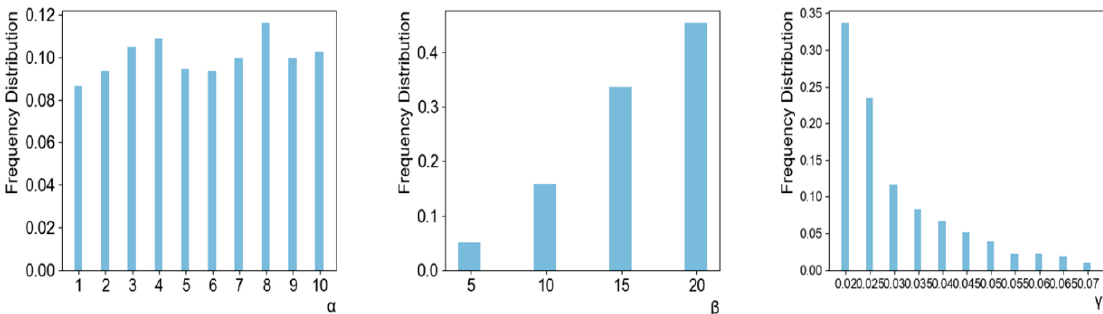
Figure 4. Frequency distributions of the best α , β , and γ values found in experiments.